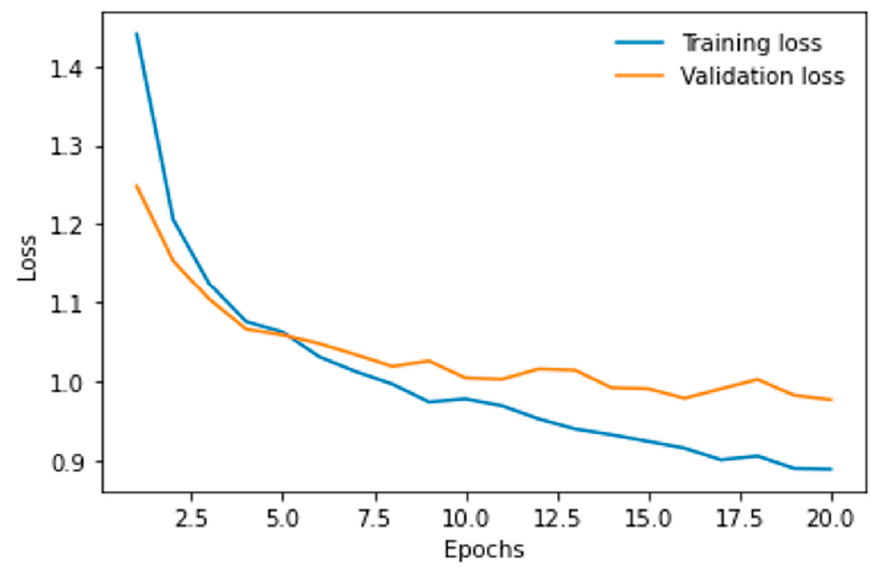
Figure 6. The Logistic Loss curve for the multi-classification model based on Resnet50.